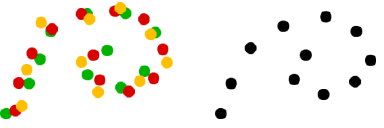
Figure 7. Time dimension in the recognition of each join /